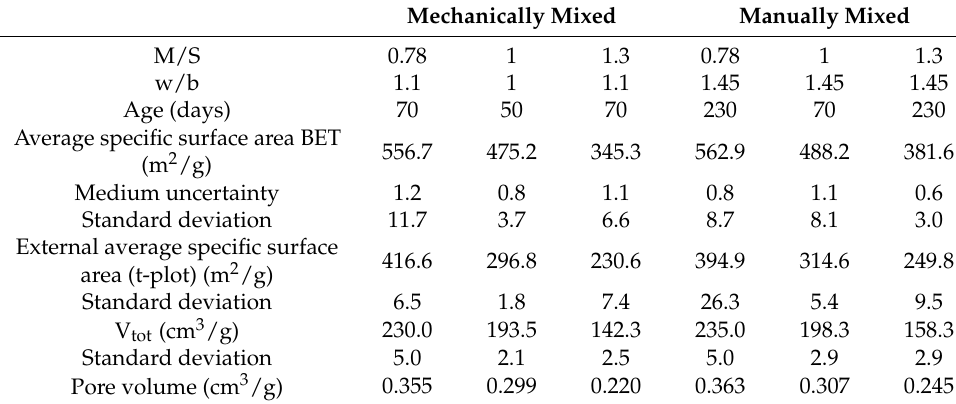
Table 5. Average specific surfaces and volume calculated for M-S-H pastes (colloidal silica and thermal cure at 50 ◦ C) using BET and t-plot methods from nitrogen isotherms. Mechanically Mixed Manually